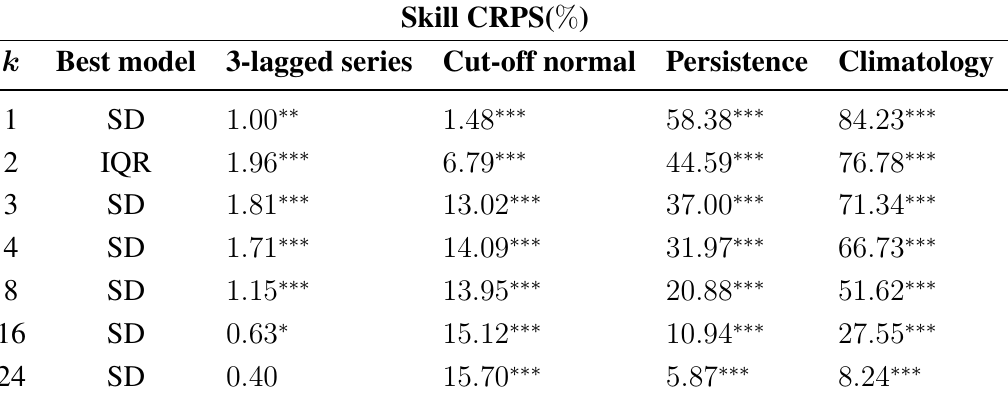
Table 10. The best performing model among the four competing ones, and its performance gain/loss with respect to the four reference (benchmark) models, for forecast horizon k (measured in 15 min steps). Reference models: 3-lagged series (column 3), Cut-off normal (column 4), Persistence (column 5) and Climatology (column 6). These results are outcomes from a 1-step ahead CFS optimization. The asterisks indicate the statistical significance of the gain/loss according to the Amisano and Giacomini test with the following significance codes for the p -value of the test: ***: p ≤ 0 . 01 , **: 0 . 01 < p ≤ 0 . 05 , *: 0 . 05 < p ≤ 0 . 1